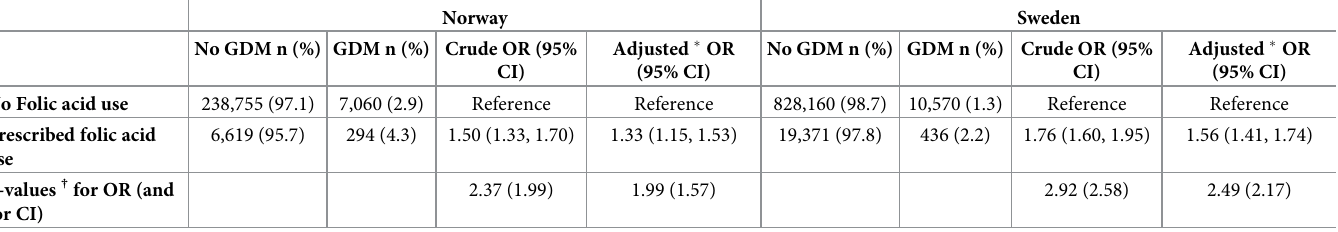
Table 4. Crude and adjusted odds ratios and 95% confidence intervals estimating the association between prescribed folic acid use and gestational diabetes in moth- ers from Norway and Sweden. Norway